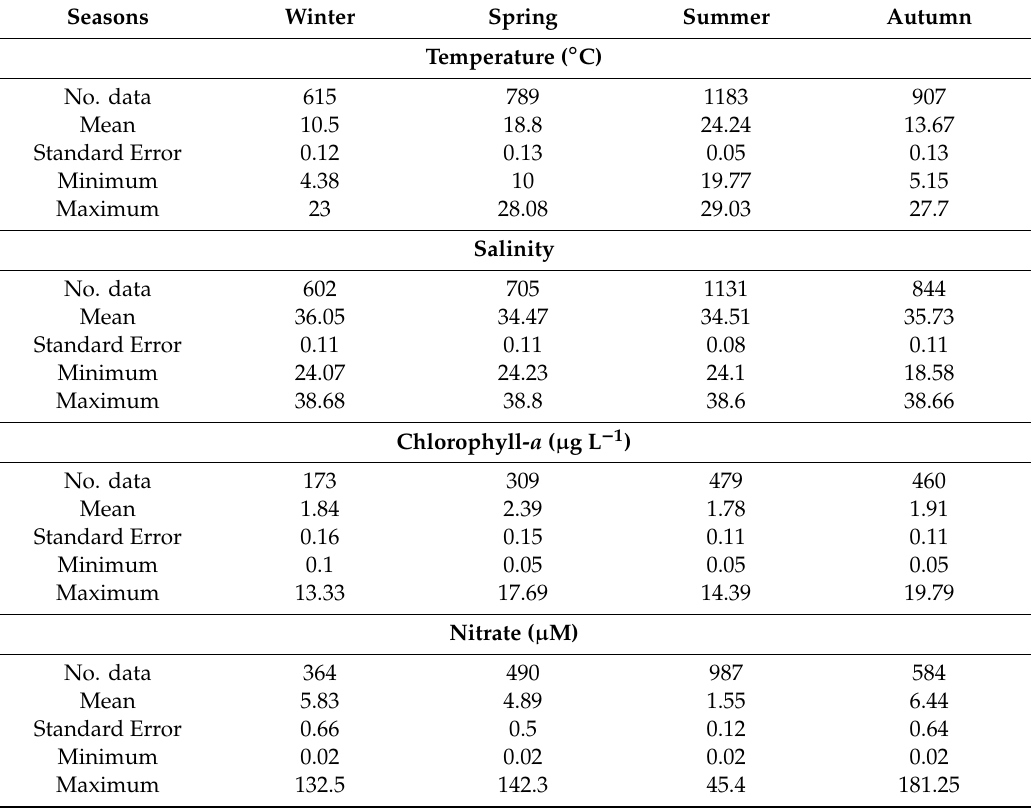
Table 1. Statistics of the seasonal dataset in seawater of temperature ( ◦ C), salinity, chlorophyll- a ( µ